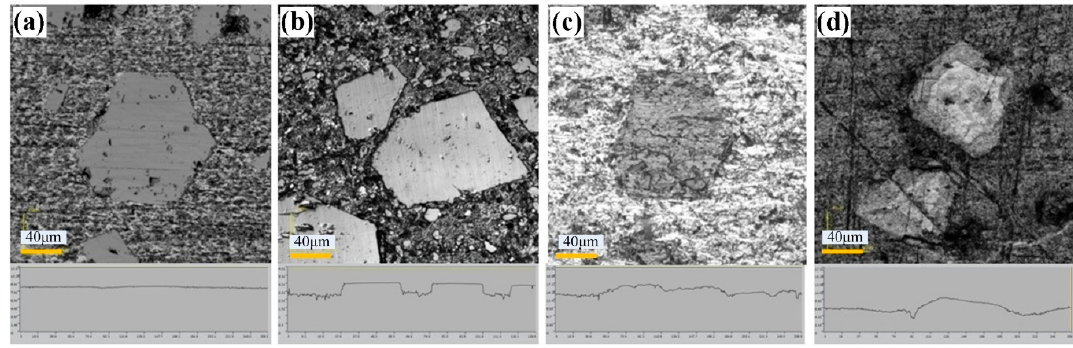
Figure 9. Polished surface morphologies and outlines of the cylinder liner: ( a ) untreated; ( b ) chemical etching; ( c ) mechanical honing; ( d ) laser finishing.